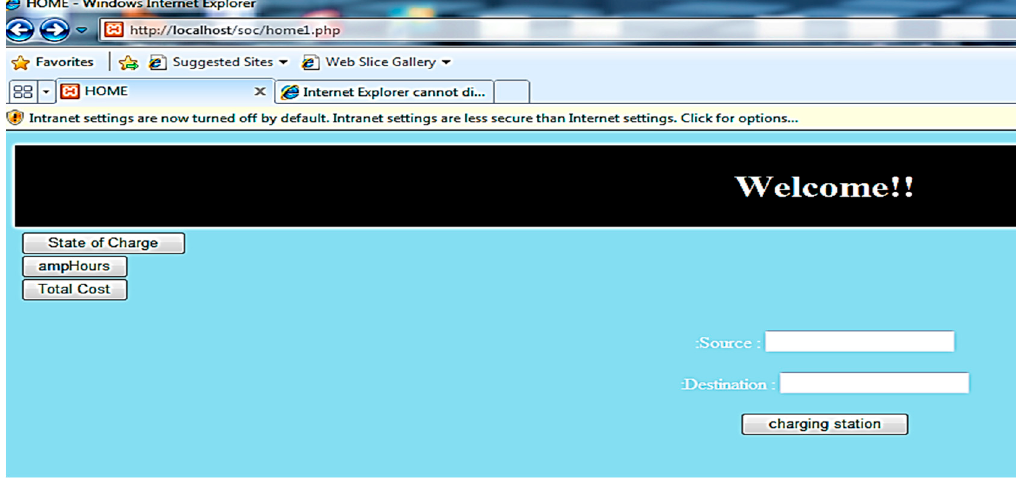
Figure 10. Homepage for charging slot reservation.